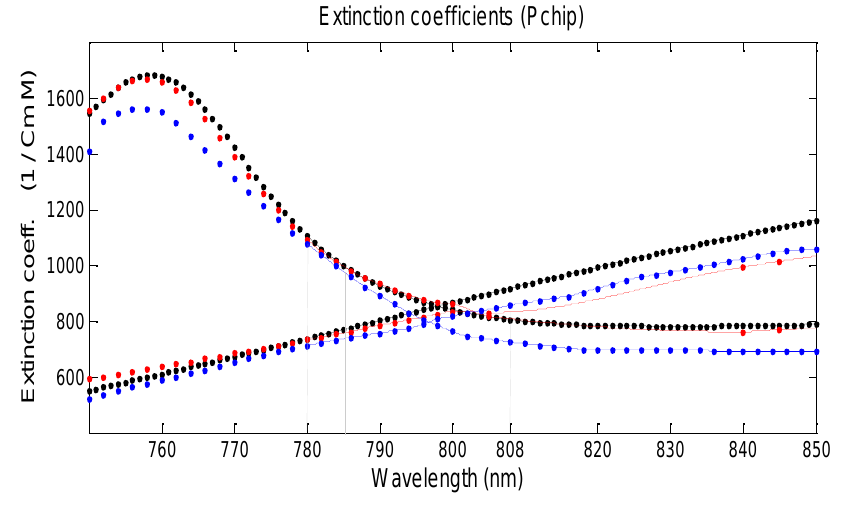
Figure 8. The extinction coefficients of Hb and HbO obtained by Zijlstra et al . (red), Cope (blue) and Prahl (Black) [25]. The red lines represent values derived from the experimental measurements of Zijlstra by means of interpolation (using the pchip command in